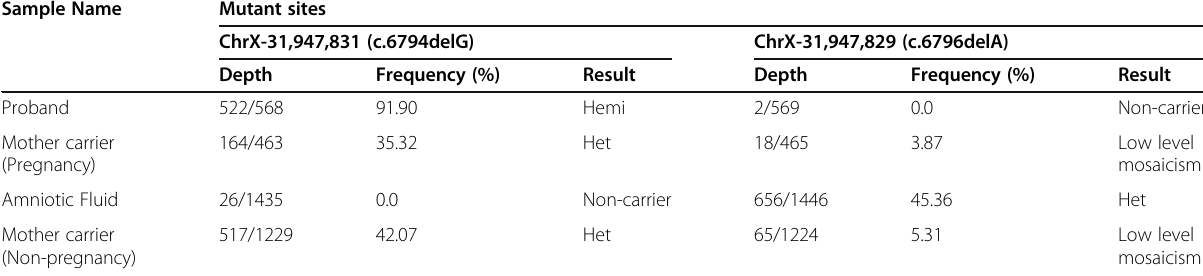
Table 1 Deep sequencing of the family members in mosaic DMD